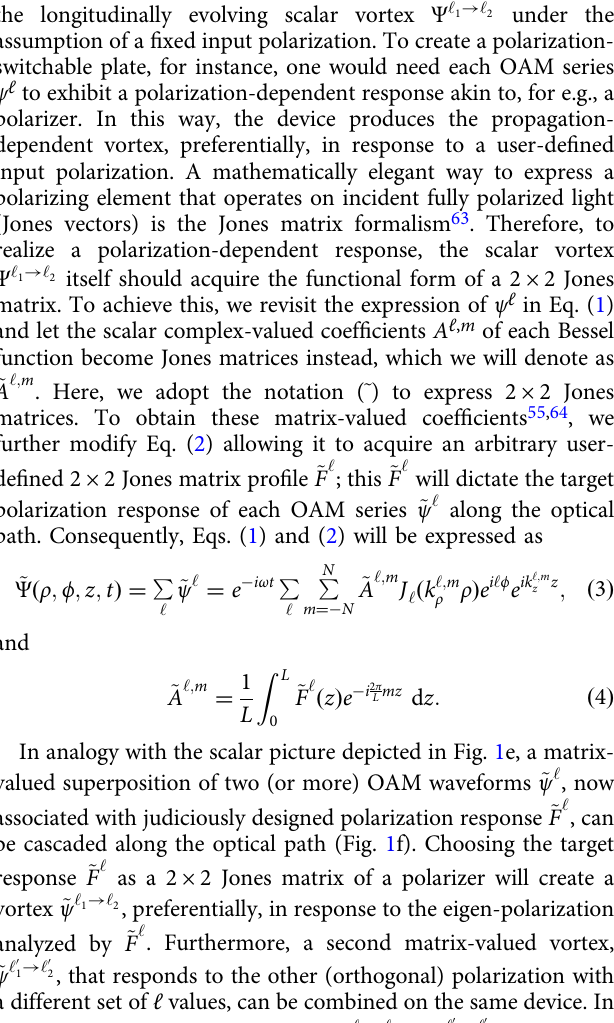
(cid:1) (cid:3) (cid:1)